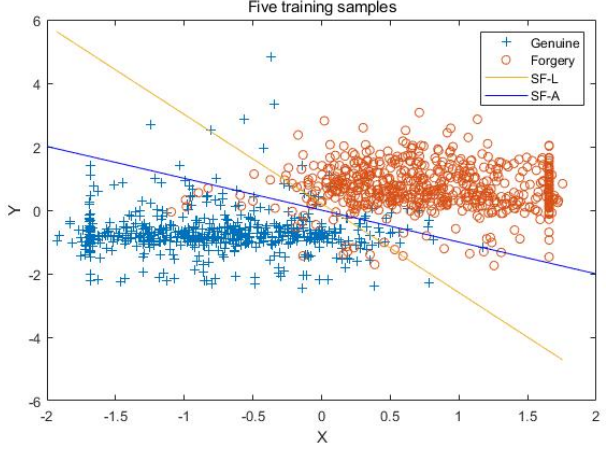
Figure 4. Sample distribution when using five training samples. Table 6. The result of eight training samples.